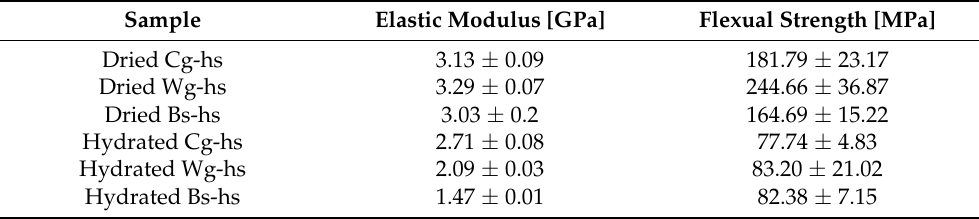
Table 3. Flexural properties of different Caprinae horn